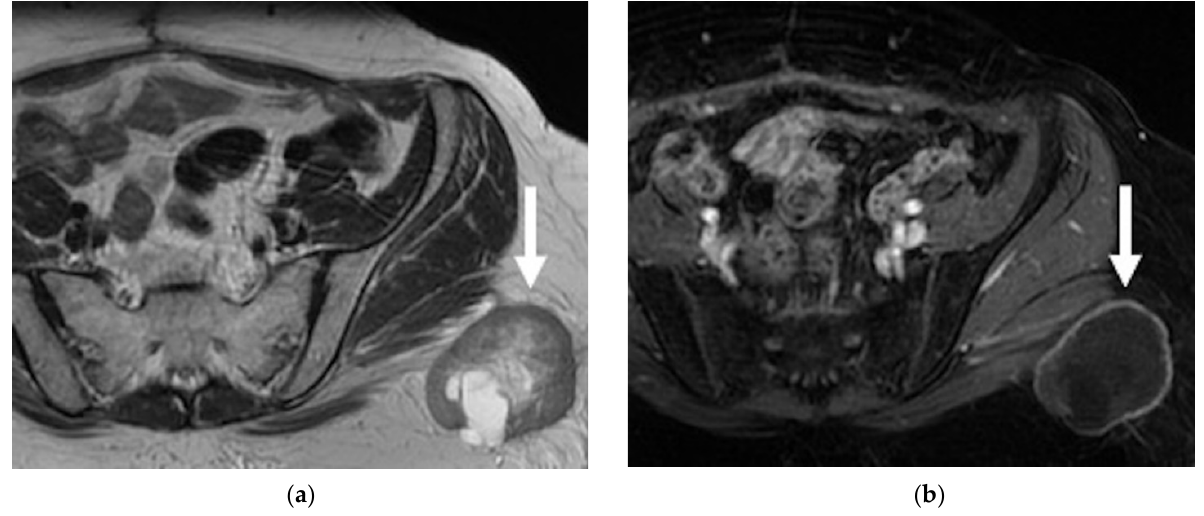
Figure 11. A 38-year-old woman who underwent radical hysterectomy with BSO and chemoradiation therapy for cervical cancer. ( a ) Axial FSE T2-weighted and ( b ) axial T1 weighted fat-sat post-contrast